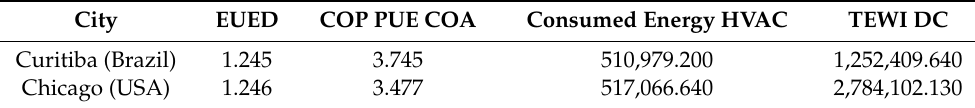
Table 10. TEWI comparison between cities for DC installation.